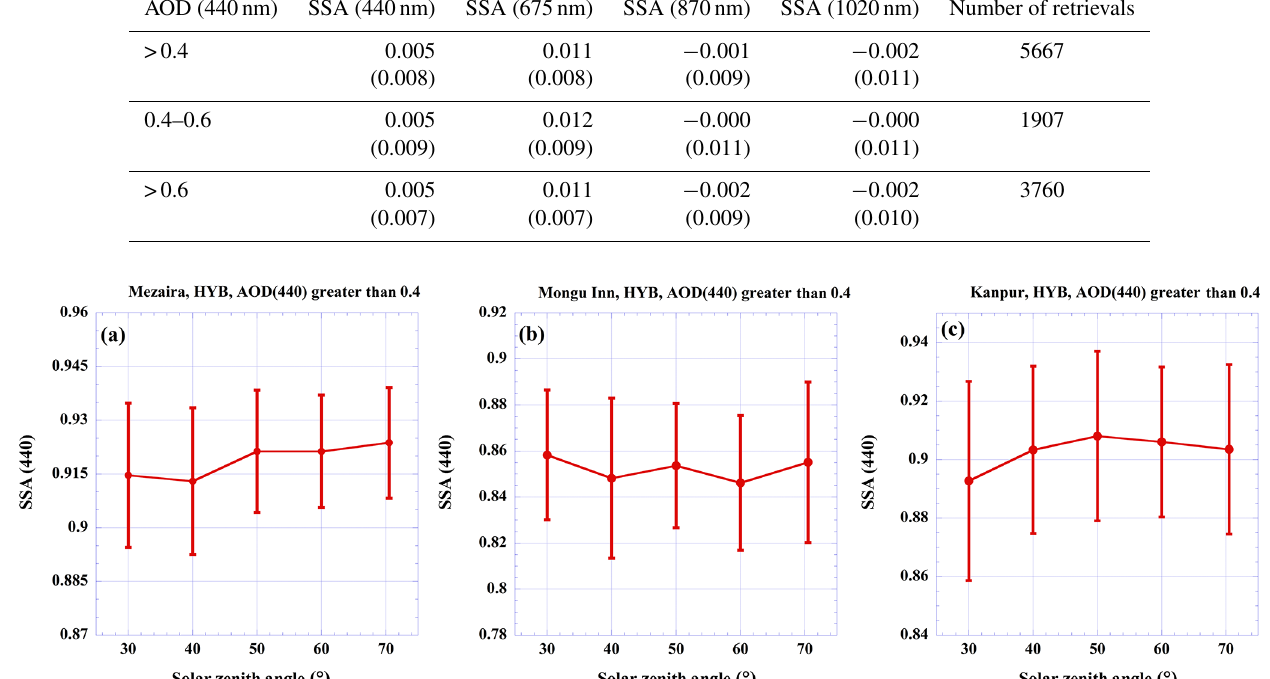
Figure 13. Dependence of 440nm SSA hybrid scan retrievals on SZA for three AERONET sites: (a) Mezaira, (b) Mongu Inn, (c) Kanpur.